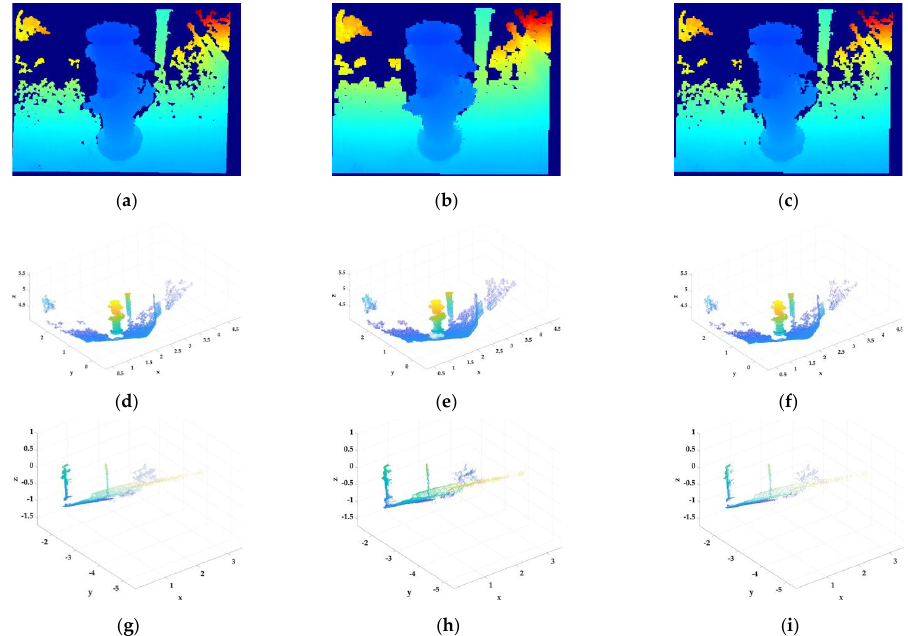
Figure 17. Validation of fractional−order differential Kriging interpolation super−resolution model (dataset no. 04797). ( a, d, g ) Original depth images; ( b, e, h ) Outputs of fractional−order differential Kriging interpolation super-resolution model ( ν = 0.6, PSNR = 40.595 dB); ( c , f , i ) Outputs of nearest- neighbour interpolation super-resolution model (PSNR = 22.456 dB).